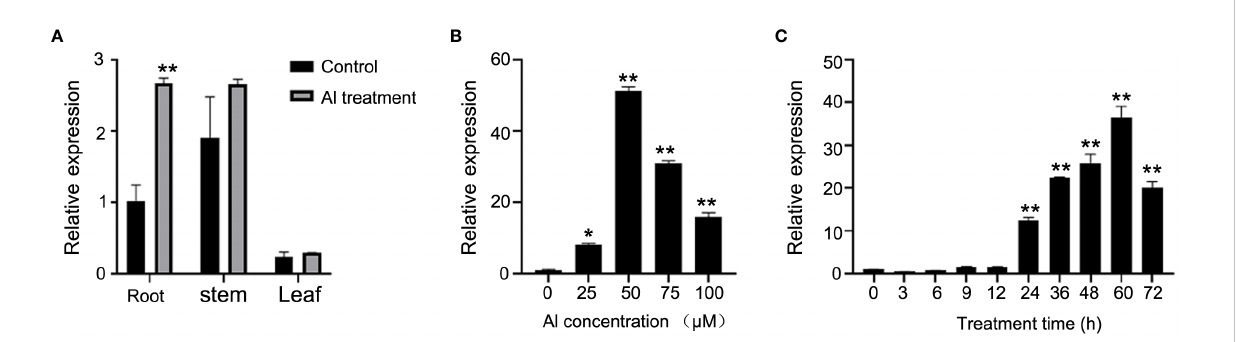
FIGURE 3 Expression pattern analysis of GmABR1 . (A) Tissue expression pattern of GmABR1 . Samples were obtained from root, stem, and leaf tissues of HX3 seedlings grown in the nutrient solutions containing 0 m M AlCl 3 and 50 m M AlCl 3 , respectively. (B) Gene expression of GmABR1 in the root of soybean cultivar HX3. The soybean cultivar HX3 was cultured for 24 h in the nutrient solutions containing 0, 25, 50, 75 and 100 m M AlCl 3 , respectively. (C) Time course expression pattern of GmABR1 in the root of soybean cultivar HX3. Using soybean Actin3 as internal reference gene, three independent replicates were detected by 2 ^- △△ CT method. The asterisks in fi gure A indicate signi fi cant differences between roots and other soybean tissues ( *P < 0.05; **P < 0.01). The asterisk in fi gure B indicates that there is a signi fi cant difference between 0 m M AlCl 3 and other Al concentration (25, 50, 75 and 100 m M AlCl 3 ) treatment ( *P < 0.05; **P < 0.01). The asterisk in fi gure C indicates that there is a signi fi cant difference between the Al treatment time of 0 h and the other Al treatments of 3, 6, 9, 12, 24, 36, 48, 60, 72 h ( *P < 0.05; **P <